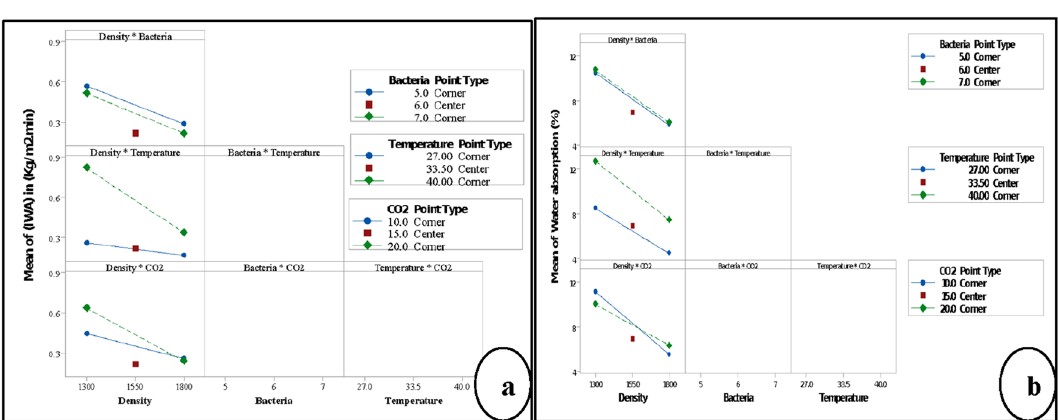
Figure 8. Interaction plot of the factors by factorial analysis ( a ) response is initial water absorption ( b ) response is water